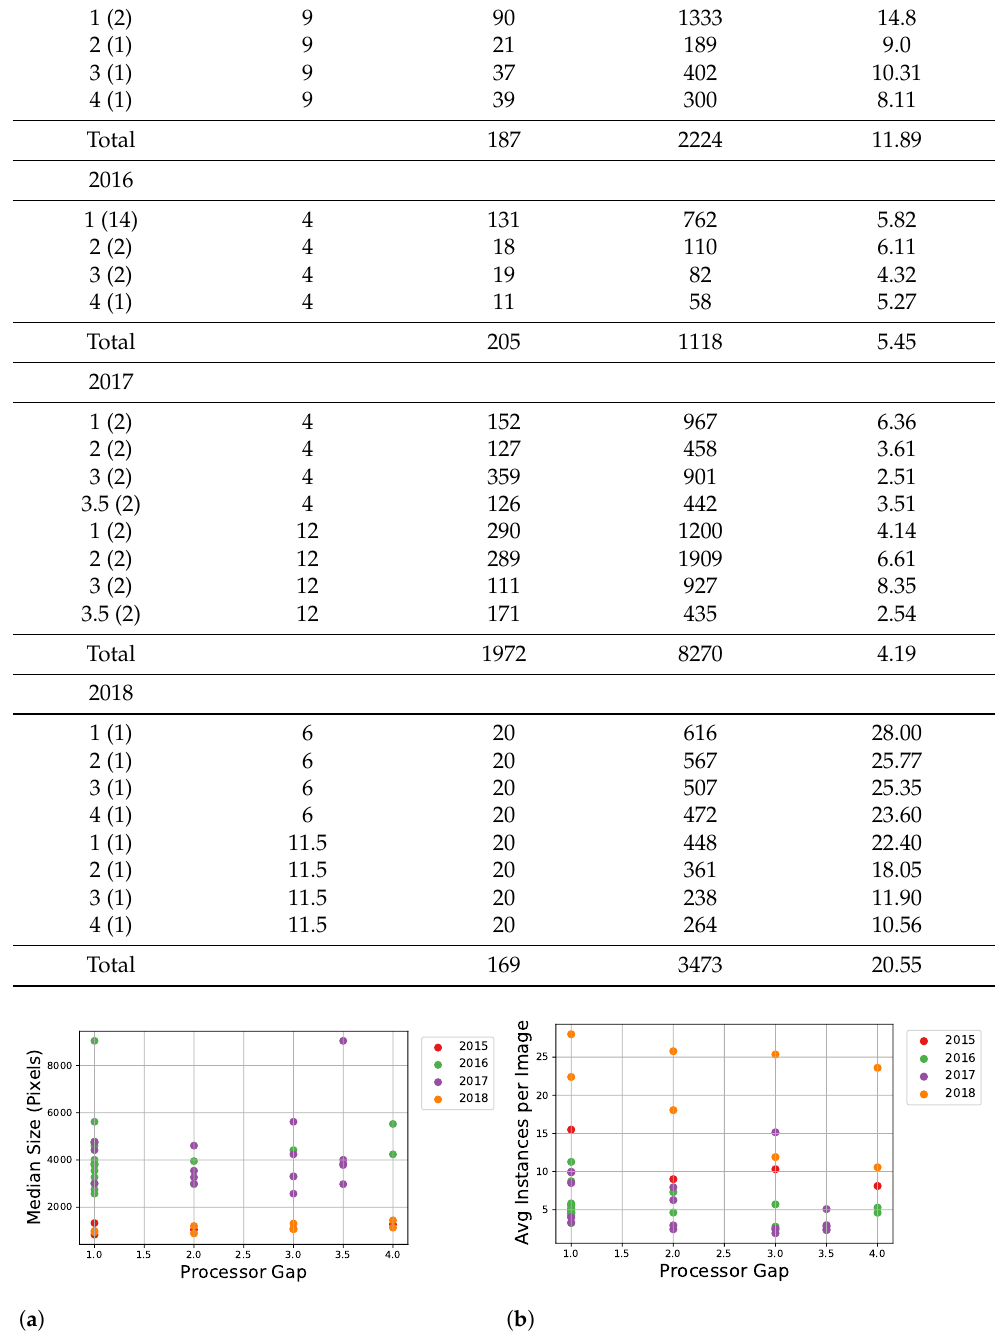
Figure 6. Median size of annotations for sequences across PGs ( a ). Average number of annotated instance for sequences across PGs ( b